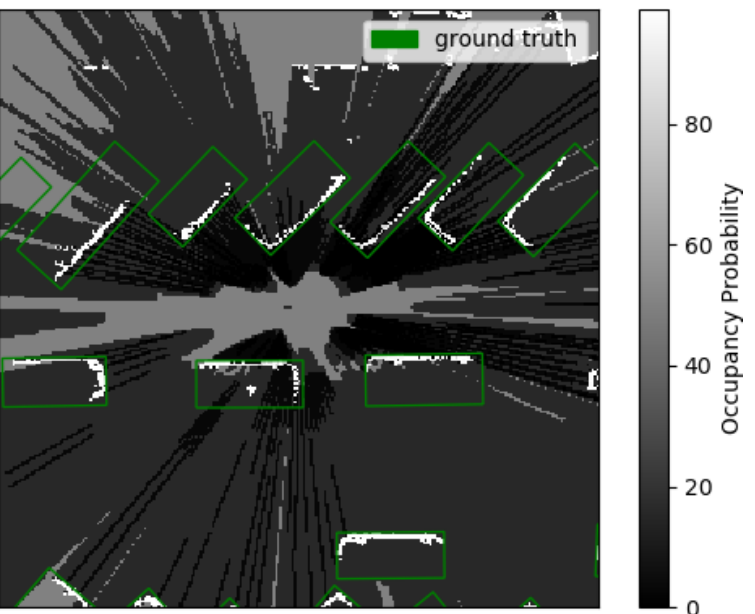
Figure 2. Occupancy grid map produced from a Waymo Open [19] frame. Green bounding boxes are ground truth vehicles. Occupancy probability is encoded in